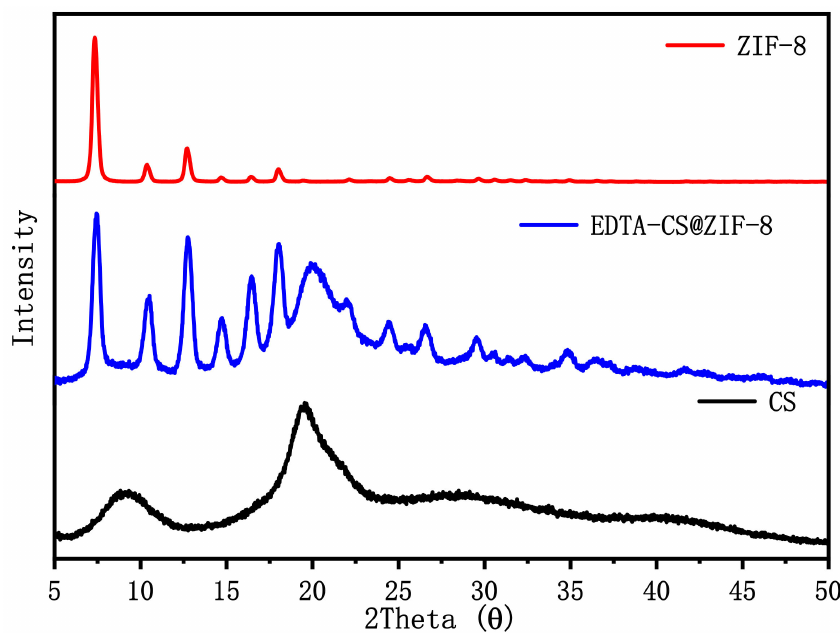
Figure 1. XRD of the zeolite imidazole framework (ZIF-8), chitosan, and ethylenediamine tetraacetic acid (EDTA)–chitosan